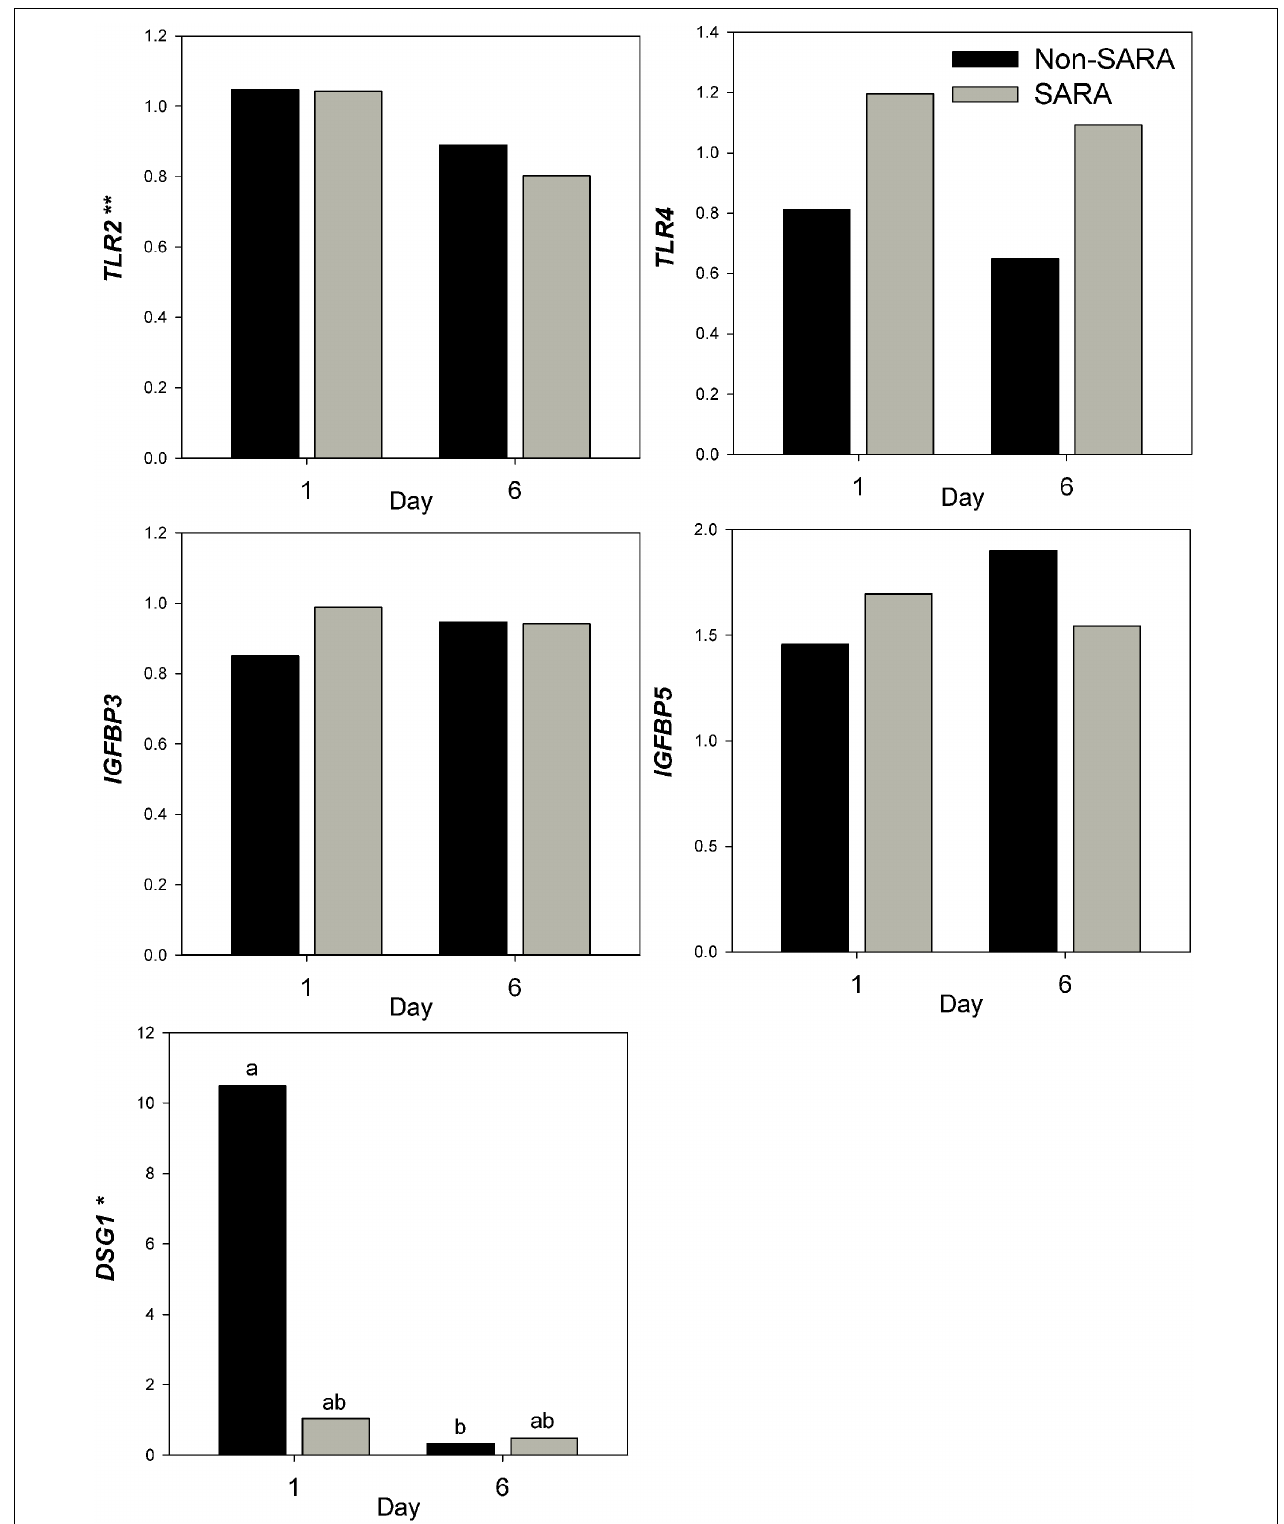
FIGURE 7 | Effect of SARA induction on gene expression in rumen epithelium tissue. Effects ( P ≤ 0.05) are indicated by symbols: day effect ( ∗ ), treatment effect (#), treatment × day effect (§), and period effect ( ‡ ). Tendencies ( P ≤ 0.1) are indicated by symbols: day effect ( ∗∗ ), treatment effect (##), treatment × day effect (§§), and period effect ( ‡‡ ). Subscripts indicate pairwise differences of P < 0.05.